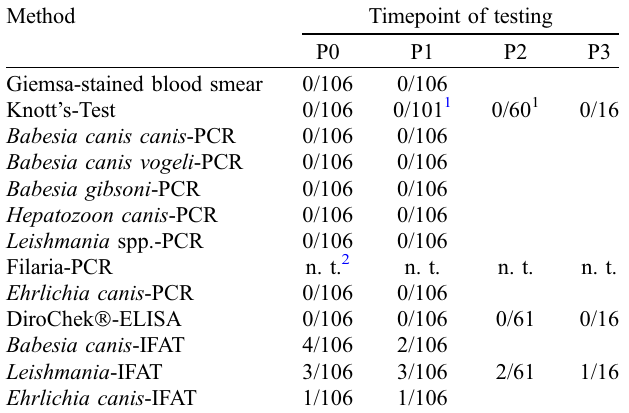
Table 2. Results of the screening for vector-borne infections in 106 travelling dogs.